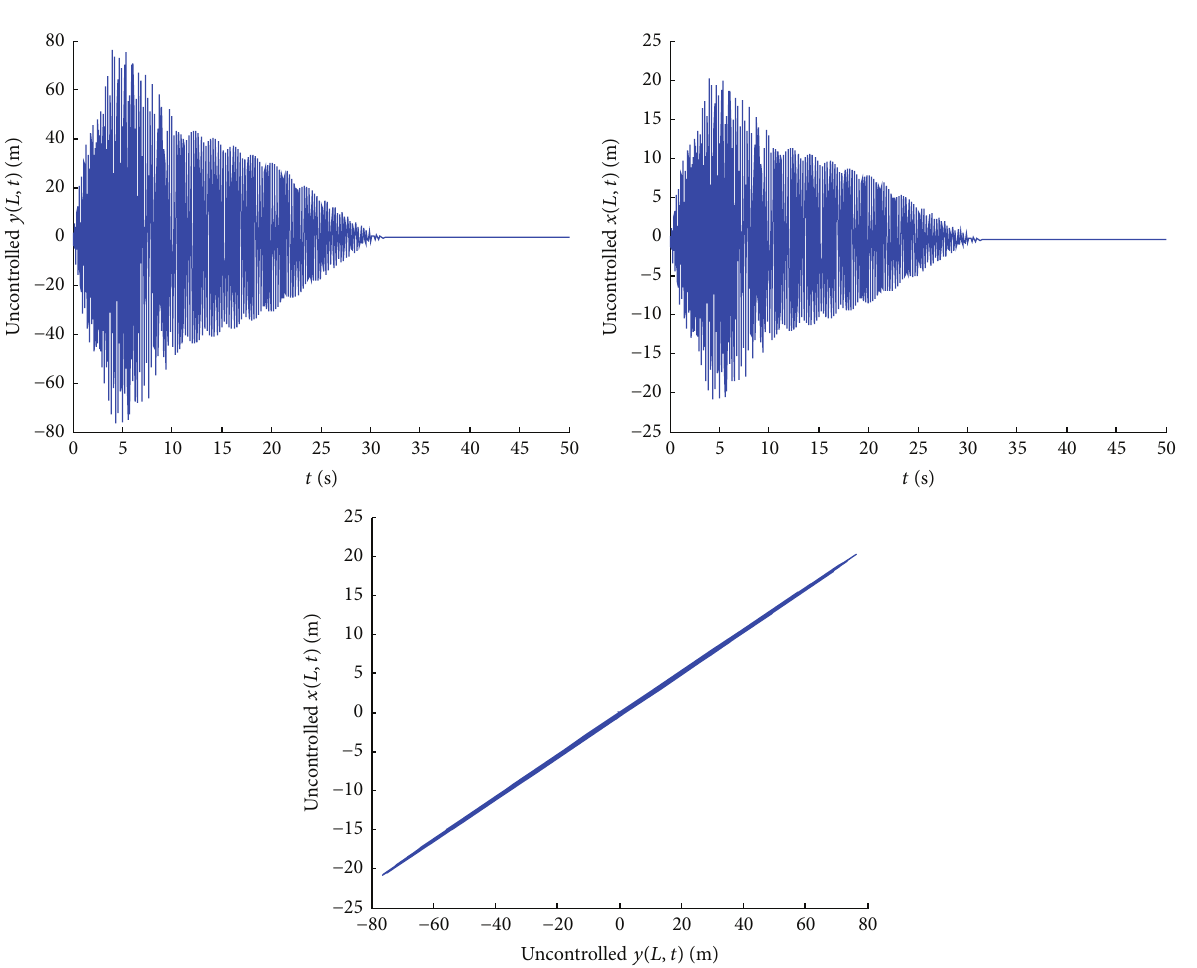
Figure 8: Uncontrolled responses and phase plane of flap/lag motions under extreme wind condition of 𝑈 = 65 m/s with zero initial